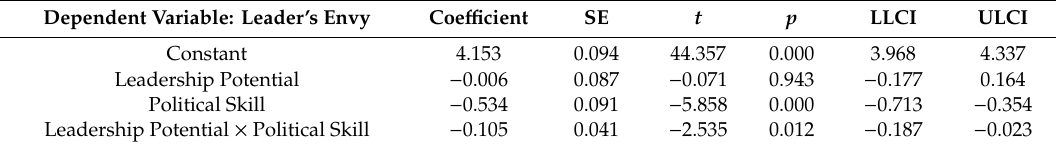
Table 9. The results of moderating effect.